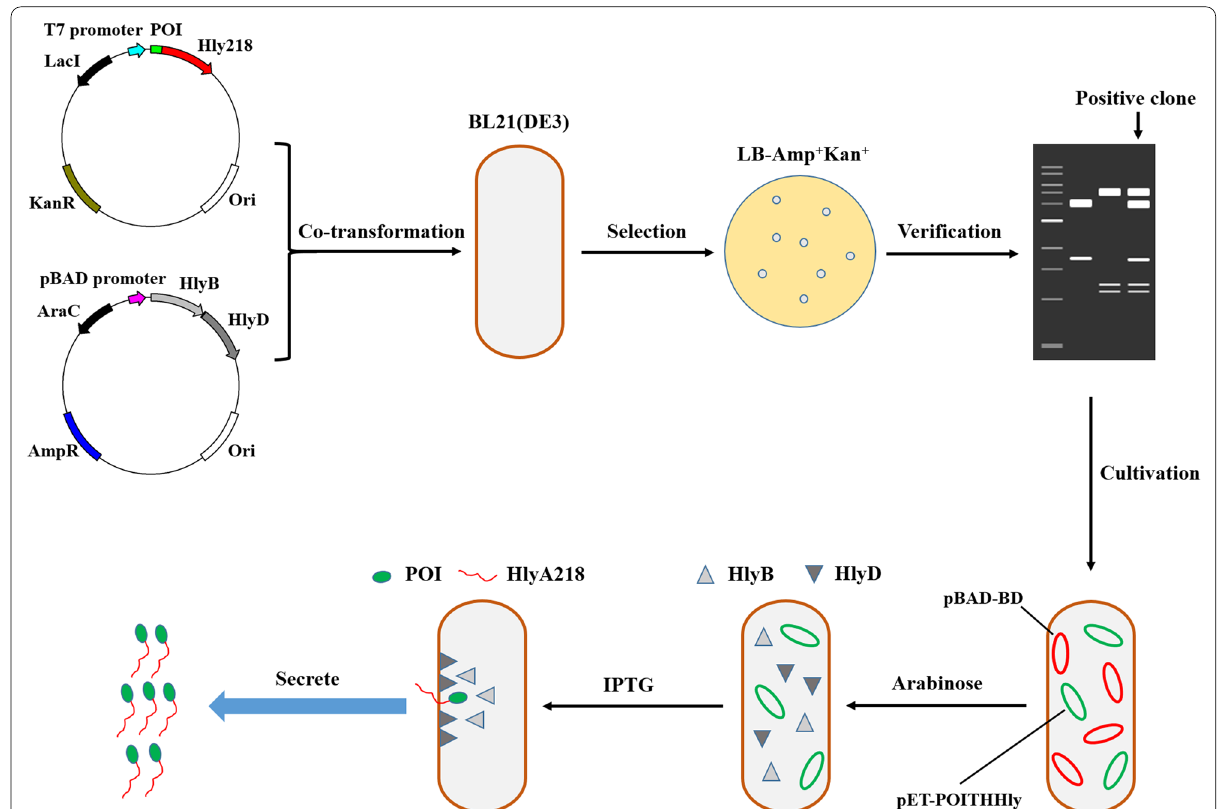
Fig. 1 Scheme of plasmids construction, expression strains selection and protein secretion. The expression plasmid and accessory plasmid were co-transformed into BL21 (DE3) and selected by LB-Amp